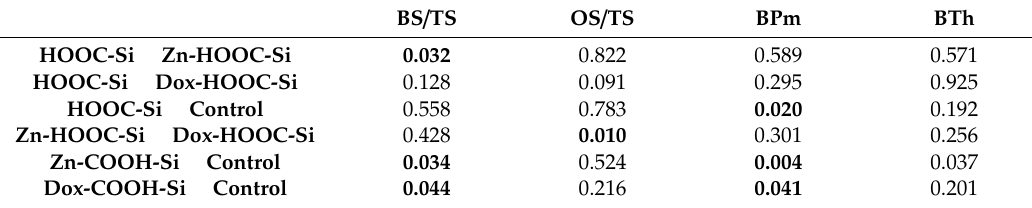
Table 2. Statistical results ( p values) after pairwise comparisons. Bold numbers mean significance at p < 0.05.